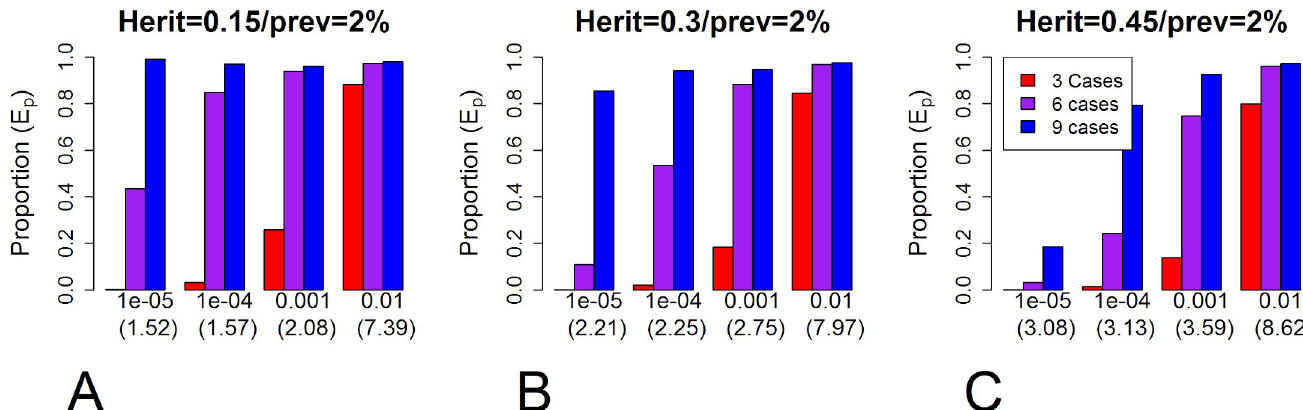
Fig 3. Proportion carrying HPRV in multi-generational families. The proportion ( E multi-generational families for a disease with a 2% prevalence (100 × π � ) in the population. Panels A, B, and C represent different values of polygenic heritability (A: s 2 ¼ 0 : 15 , B: s 2 ¼ 0 : 30 , C: s 2 ¼ 0 : 45 ). Within a panel, the four sets of bars represent different MAF ( p P P P parenthesis is the resulting Sibling Relative Risk). Within a set of bars, the colors represent the different numbers of total affected individuals (red: n D purple: n D þ n D ¼ 6 , blue: n D þ n D ¼ 9 ). See Supporting Information: S3 Fig for diseases with other 1 2 1 2